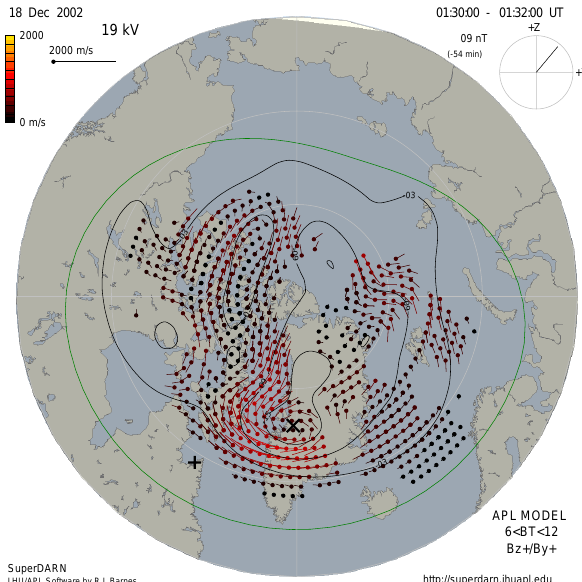
Fig. 10. Contours of the SuperDARN electric potential pattern for 01:30UT on 18 December 2002, showing sunward flow across the polar cap. The short lines indicate the magnitude and direction of the ionospheric drift velocities measured by the